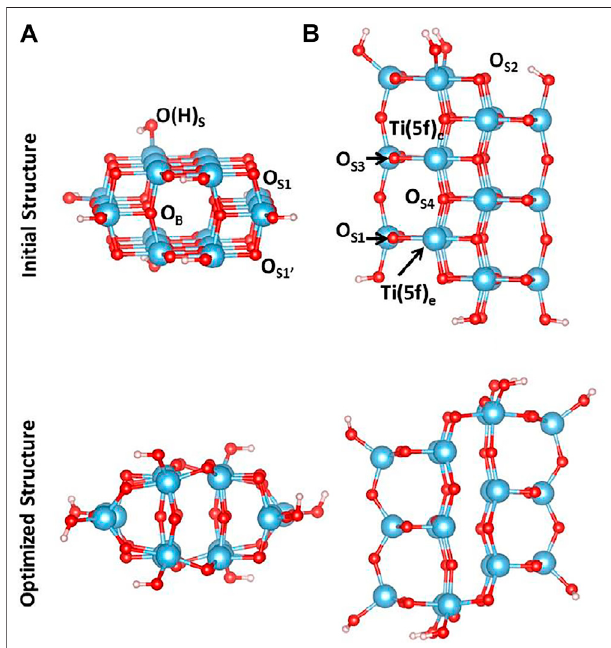
FIGURE 1 | (A) Side and (B) top view of initial (top) and optimized (bottom) structures at the B3LYP level of theory of the cluster model containing 68 atoms. Color code: O, red; H, white; Ti,